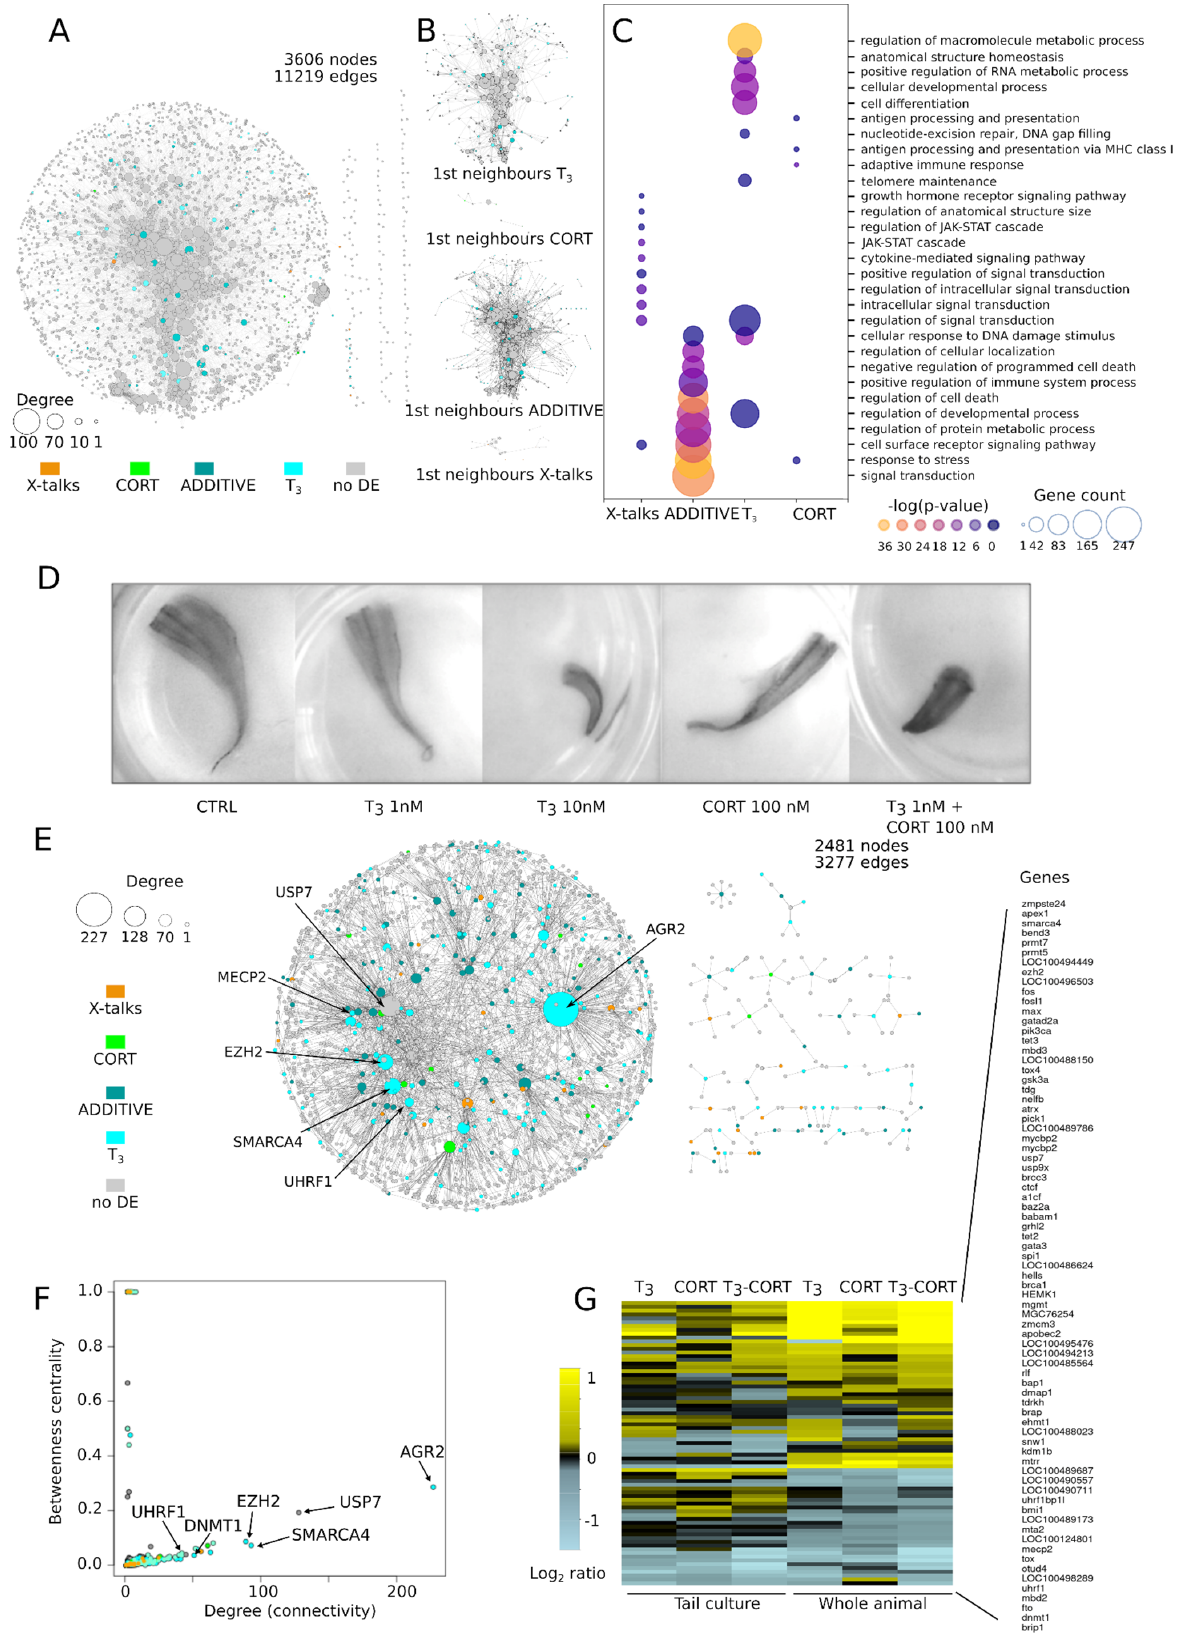
Figure 4. System level modeling of transcriptional responses identify the DNA methylation dynamic as a major mediator